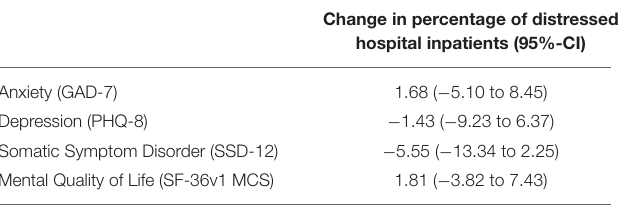
TABLE 4 | Change in percentage of hospital inpatients with poor mental health according to the mental health assessment tools from periods of modest to strong coronavirus disease 2019 (COVID-19) restrictions, based on linear regression models ( N =